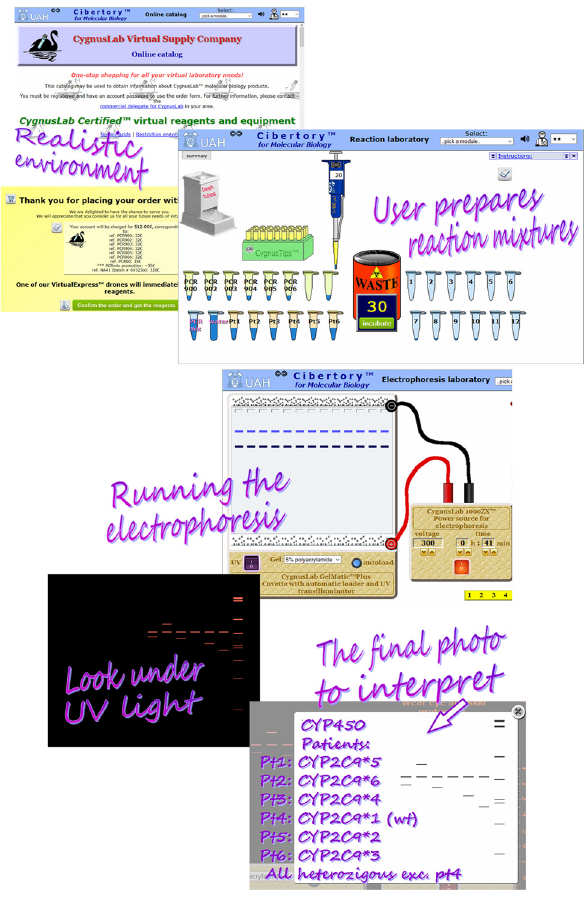
Figure5: Summarisedview of severalstepsalongthe experimentin the Cybertory virtual laboratory. Taken from ref. [8], Creative Commons BY-NC-SA